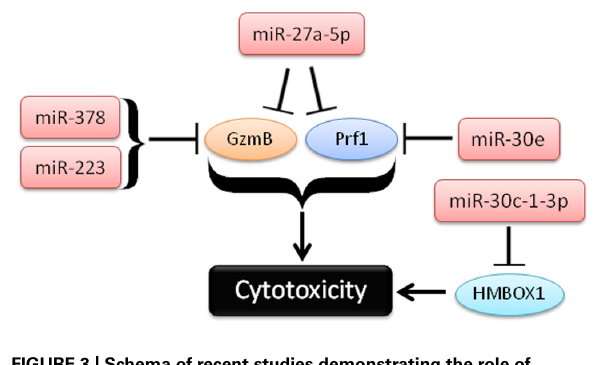
FIGURE 3 | Schema of recent studies demonstrating the role of miRNAs in repression of cytotoxicity by NK cells.